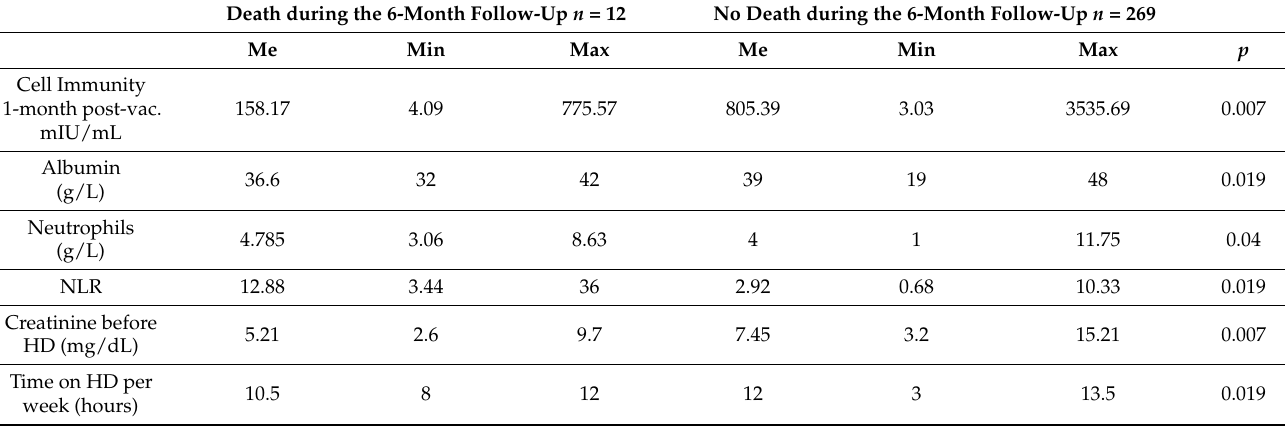
Table 3. Statistically significant differences between the groups with and without death during the 6-month follow-up after the end of the vaccination course.